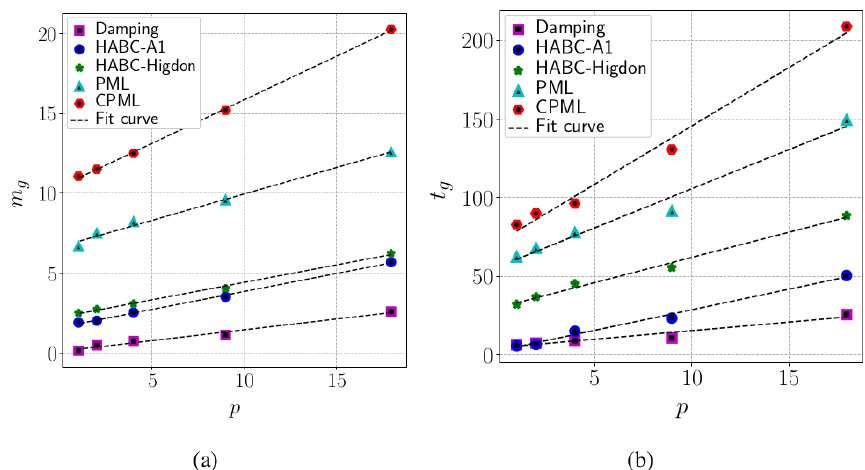
Figure 13. The percent growth of memory usage (a) and time of simulation (b) , as compared to the no-ABC case. The measures are related to the execution of the forward solver. The velocity model was part of the Marmousi, with the settings shown in Table 1.